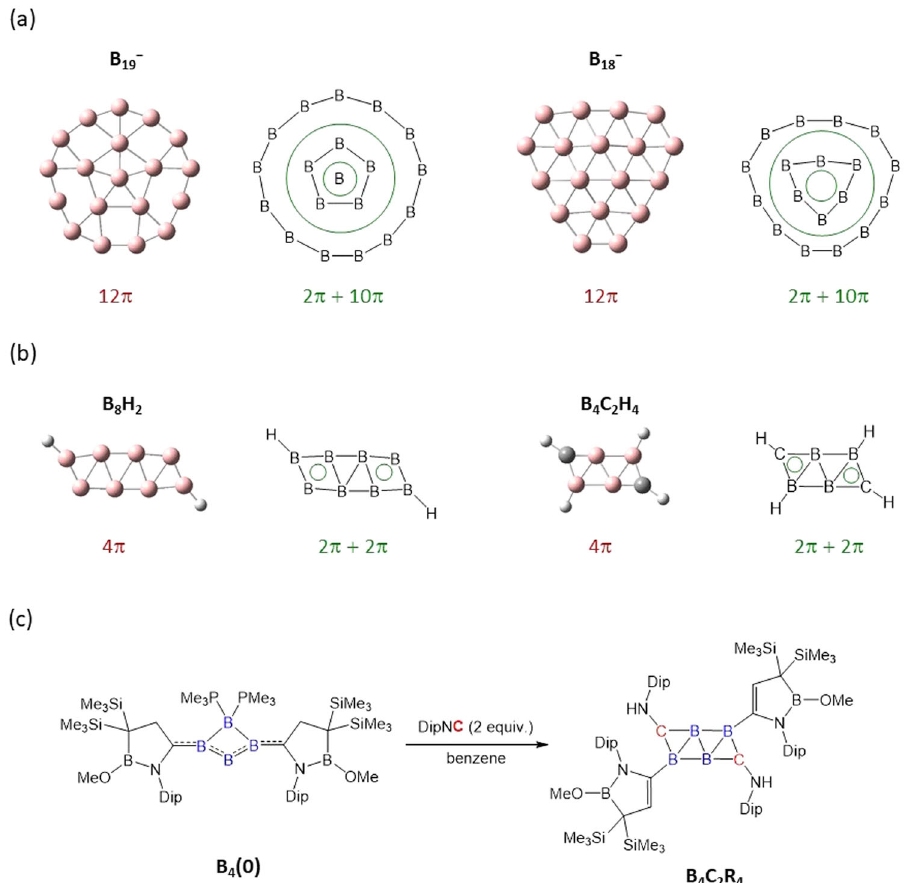
Fig. 1 Aromatic boron species with globally 4 n π electrons. a Molecular structures and schematic drawings of concentric doubly π -aromatic systems. b Molecular structures and schematic drawings of ribbon aromatic systems. c Synthesis of isolable B 4 C 2 carborane (Dip = 2,6-diisopropylphenyl. Me =